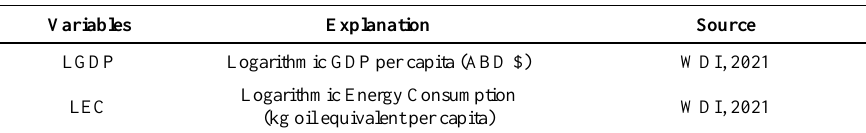
Table 1. Description of